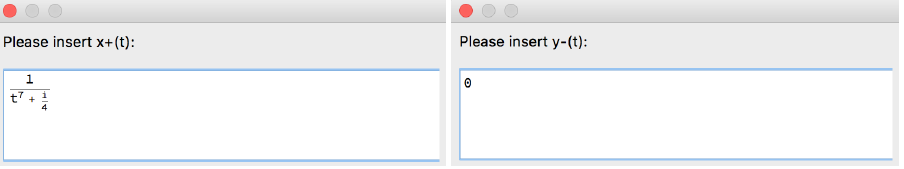
Figure 21. Part of the structure of the [SInt] algorithm corresponding to Option 1 to input r .